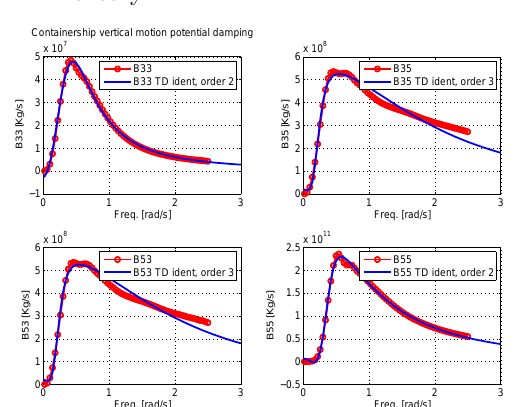
Figure 7: K 33 ( jω ) and ˆ K 33 ( jω ) based on Realization theory.